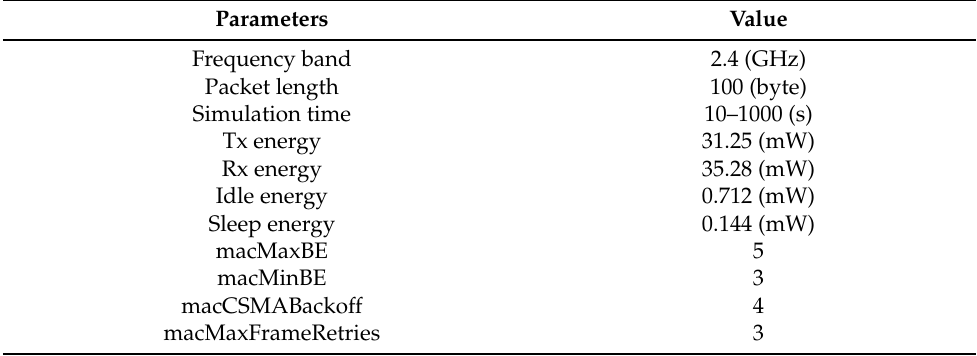
Table 1. Simulation parameters.